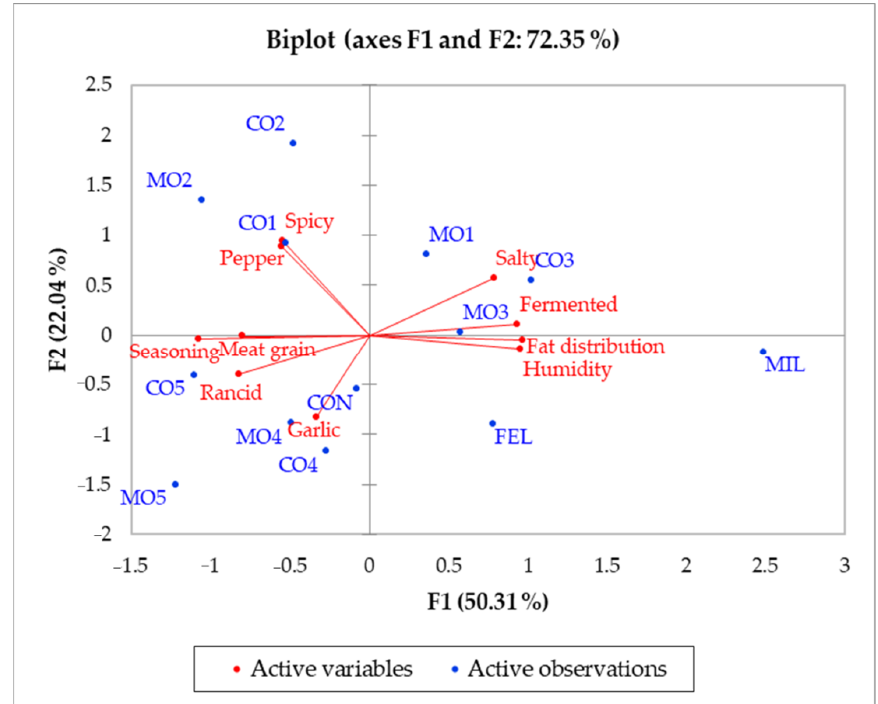
Figure 1. Principal component analysis (PCA) biplot for the sensory results. Samples were coded as CO1 (conventional salami with small size), MO1 (Mora Romagnola salami with the same size as CO1), CO2 (conventional salami of “Nostrano” type), MO2 (Mora Romagnola salami similar to CO2), CO3 (conventional salami of “Cacciatore” type), MO3 (Mora Romagnola salami similar to CO3), CO4 (conventional salami obtained directly from a local producer), MO4 (Mora Romagnola salami similar to CO4), CO5 (conventional salami obtained directly from a local producer), MO5 (Mora Romagnola salami similar to CO5), CON (conventional salami of “Contadino” type), FEL (conventional salami of “Felino” (PGI) type), and MIL (conventional salami of “Milano”